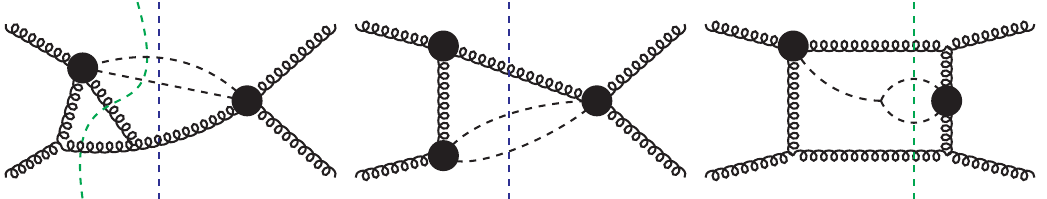
Figure 3: Forward-scattering diagrams which contribute to the real-real and real- virtual corrections to NNLO double–Higgs boson production. The blue and green dashed lines denote three- and four-particle cuts through the final state particles.